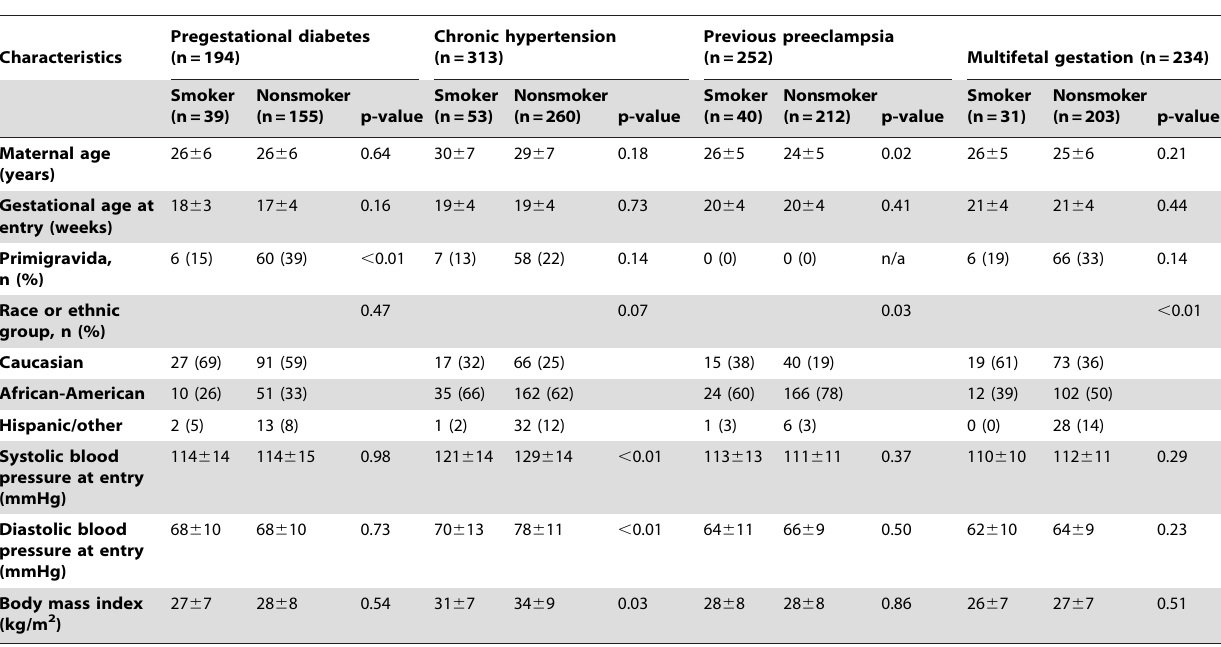
Table 1. Baseline characteristics of women at high risk for preeclampsia.*